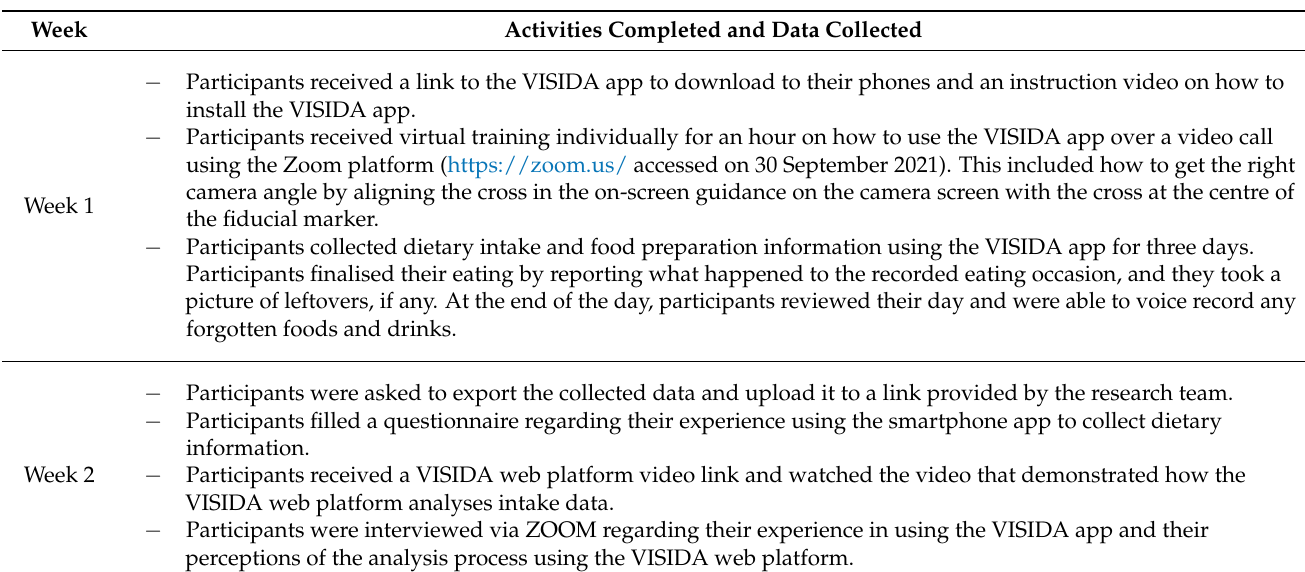
Table 1. Data collection framework for the nutritionists’ study. Activities Completed and Data